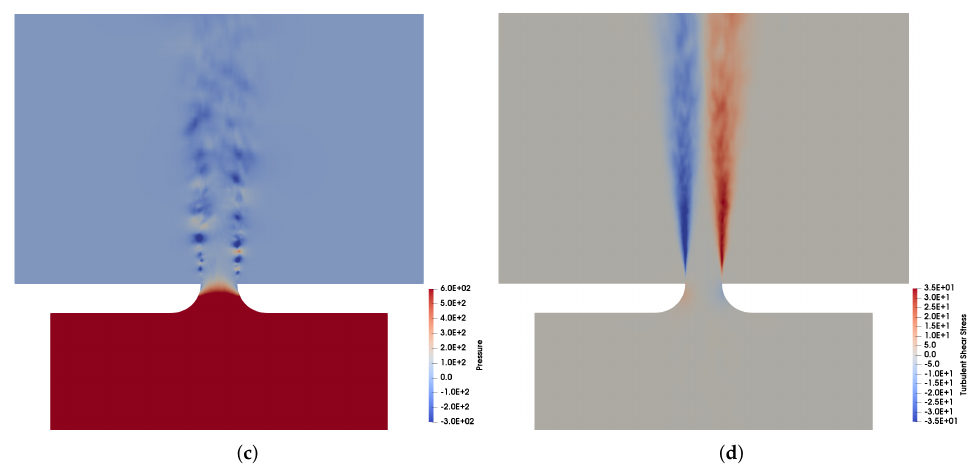
Figure 3. Field contours illustrating the shear layer development through the orifice with the expected turbulent scales appearing in the instantaneous velocity contours while the smoother time-averaged contours show the growth of the shear layers on moving downstream. Pressure fluctuations appear periodically as a result of the developing shear layer instabilities near the orifice exit, while the turbulent shear stress contours help identify regions of high turbulent mixing. ( a ) Instantaneous Velocity. ( b ) Mean Velocity. ( c ) Static Pressure. ( d ) Turbulence Shear